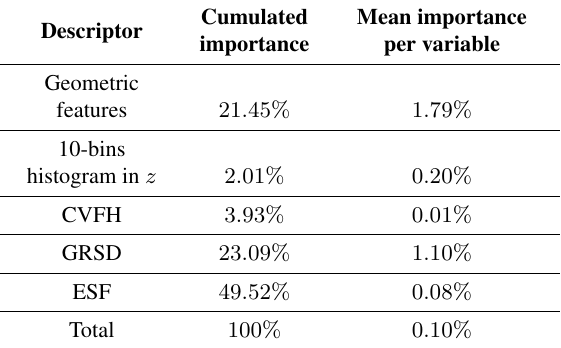
Table 3: Cumulated importance of each descriptor and Mean im- portance per variable (given by